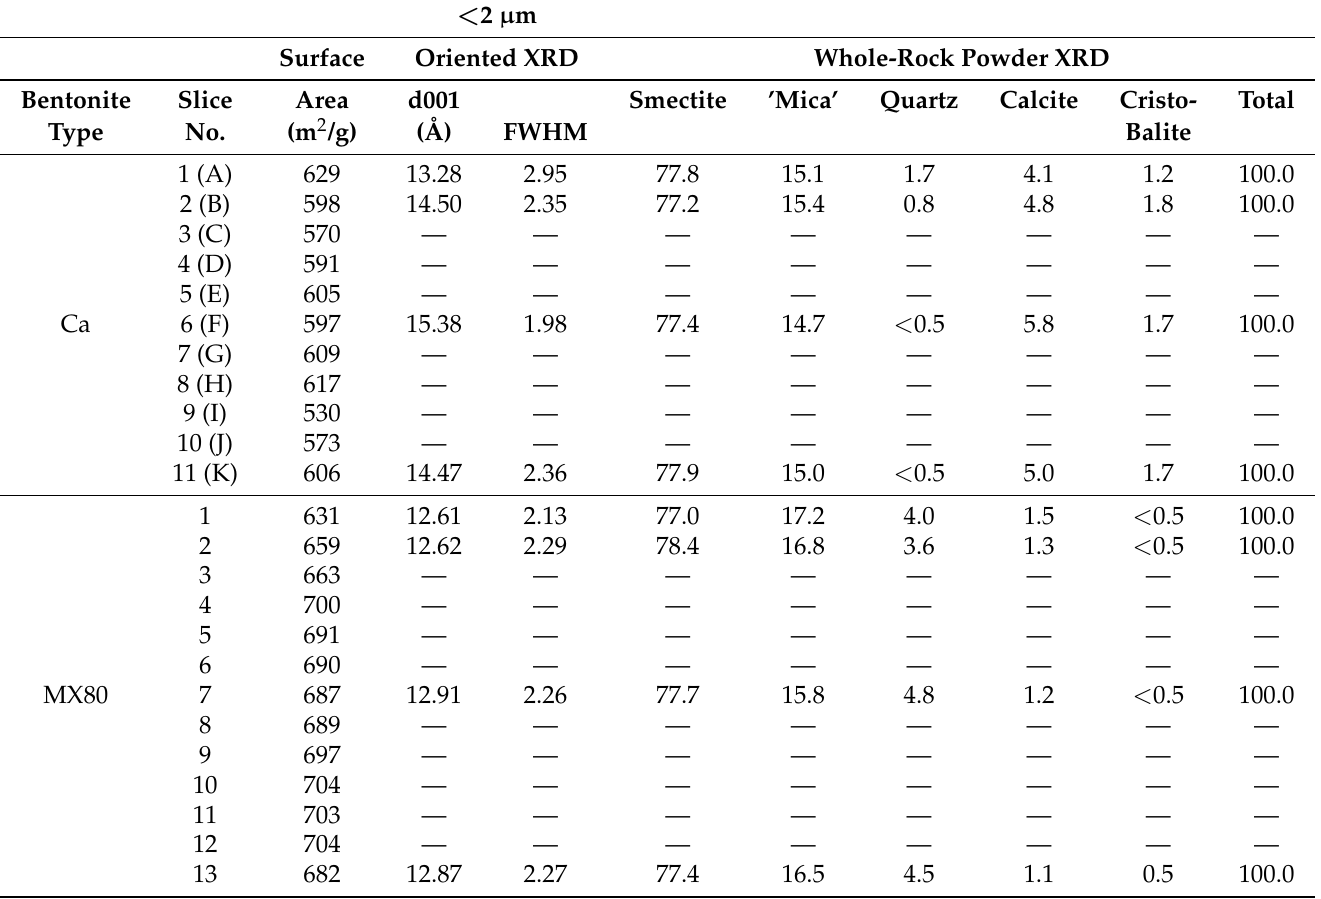
Table 2. Surface area, < 2 µ m oriented and whole-rock powder XRD data. Analyses have been carried out on the Bulgarian Ca bentonite sample as well as a comparable MX80 sample (Test 4) from Harrington et al. [47]. The piece of each slice used is given in brackets in column 2. ’Mica’ indicates undifferentiated mica species possibly including muscovite, biotite, illite,